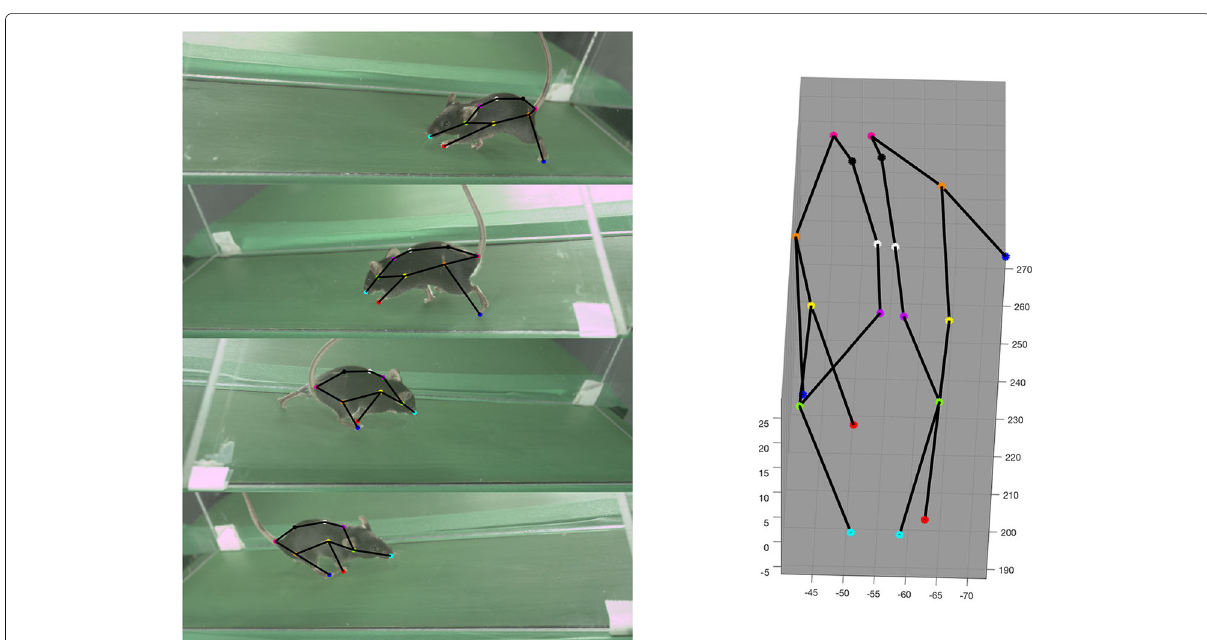
Fig. 9 3D reconstruction for a few landmarks. On the left, four camera frames are shown with ten markers. We bleached four markers on the body of the mouse to make tracking easier for the body. In addition, ear, tail, nose, two paws, and top of the curve of the body are the other six landmarks. The 3D reconstruction of these ten markers is illustrated on right